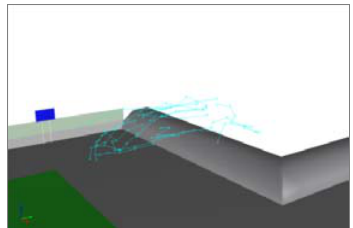
Figure 10. Paths of particle obtained by the Inertial stereo